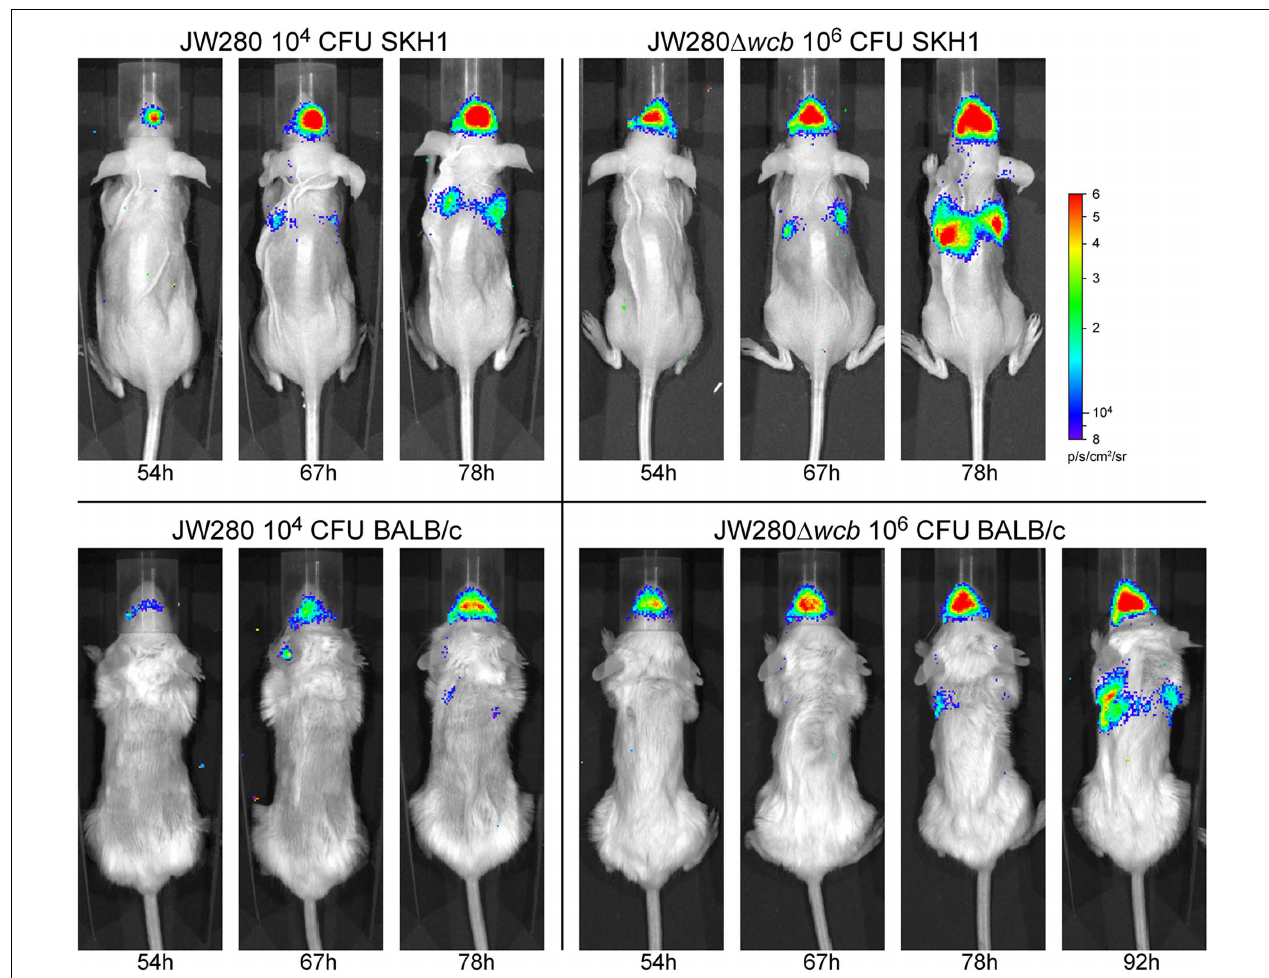
FIGURE 6 | In vivo detection of a developing B. pseudomallei infection. Overlay images captured with an IVIS Lumina system of representative SKH1 and BALB/c mice infected i.n. with JW280 (10 4 CFU) or JW280 (cid:2) wcb (10 6 CFU). Infected mice were imaged twice daily and images from late infection (54–92h) are presented until the time point at which mice were euthanized due to terminal disease. All images were normalized to the same photon saturation scale.